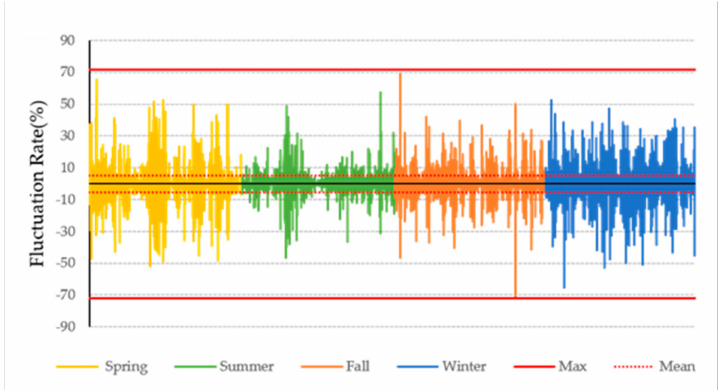
Figure 3. Hourly fluctuation rate for a year of wind power outputs in wind farm